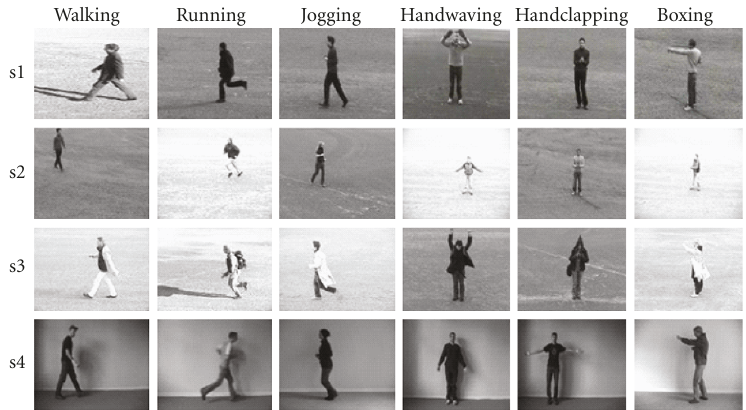
Figure 5: Example images from video sequences in KTH dataset (publicly available at http://www.nada.kth.se/cvap/actions/). This dataset was benchmarked with both unsupervised and supervised methods in the current study.